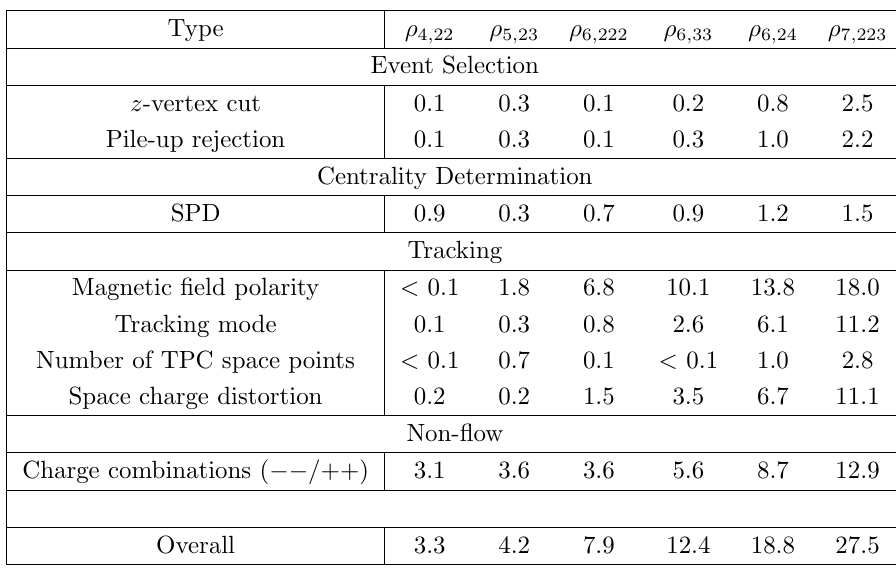
Table 3 . Relative systematic uncertainties of the symmetry-plane correlations (cid:26) n;mk .